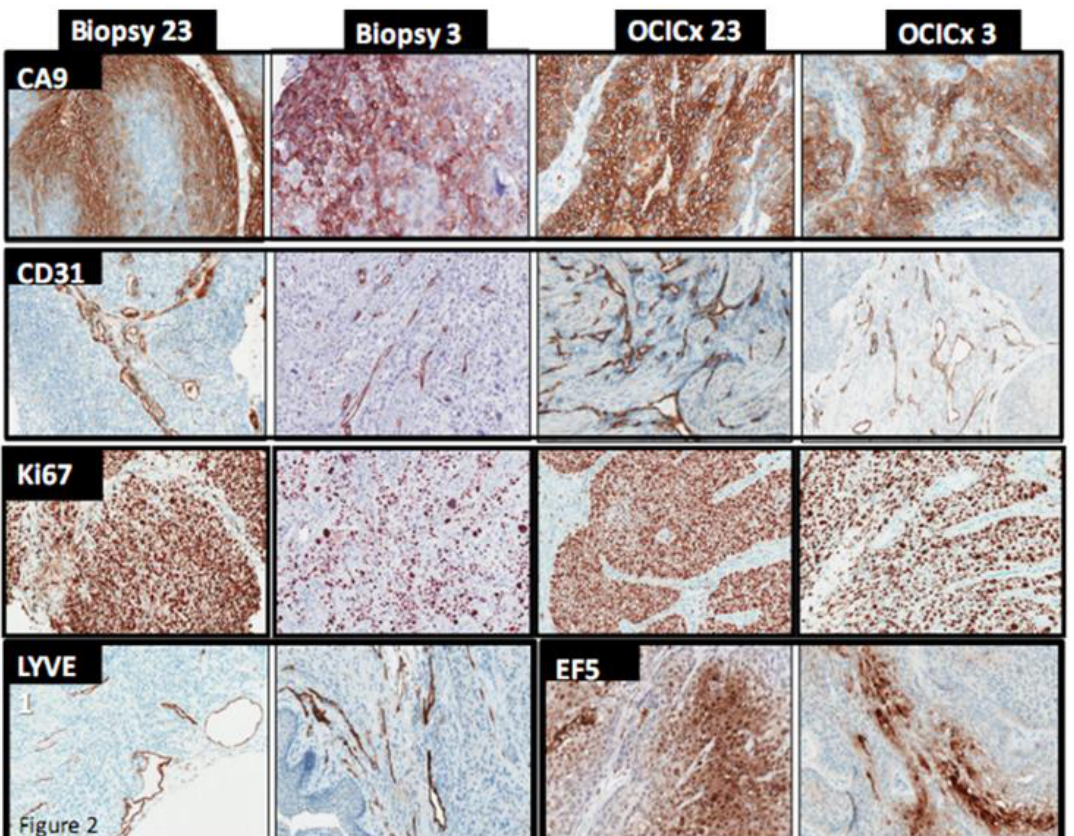
Figure 2. Hypoxia, blood vessel and proliferation staining. IHC staining in the Biopsy 23 and Biopsy 3 respectively for CA-9, EF5, CD31, Ki67 and LYVE1. 15×